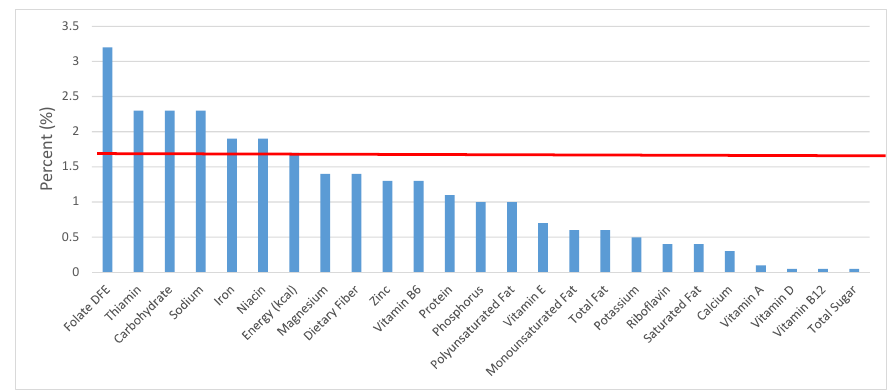
Figure 18. Cooked grains as sources of energy and nutrients for children 4–8 years old ( N = 1917, daily intake data): DFE = Dietary Folate Equivalents; solid red line represents percentage of energy (kcal) provided in the diet relative to nutrients—nutrients above the red line show the grain food’s contribution to nutrient density.